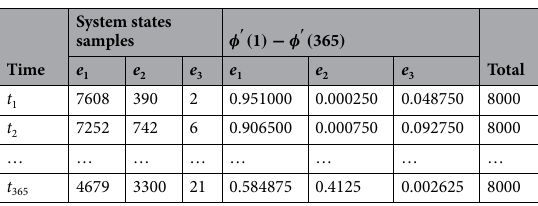
Table 4. System states statistics.